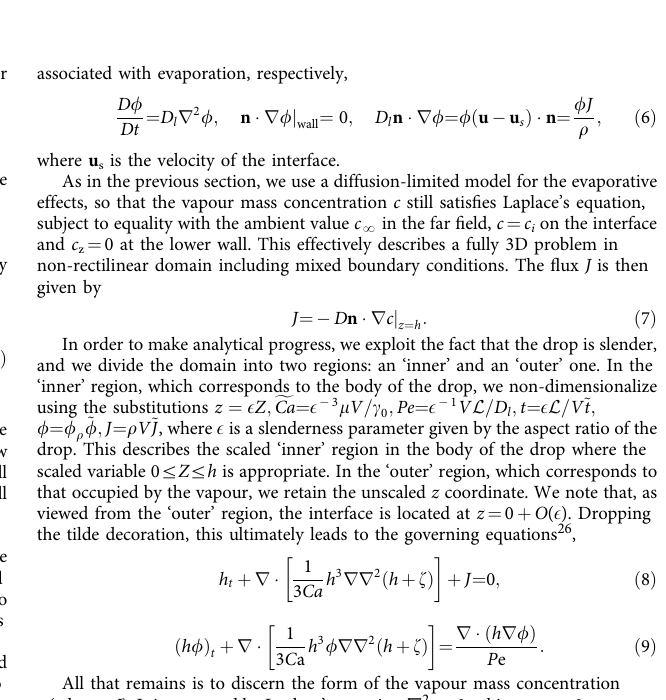
Figure 9 | Local evaporation flux. Parameter values are as in Fig. 8. ( a ) Two-dimensional plot of the flux, J ; ( b ) overlaid height (solid line) and flux (dashed) line corresponding to dashed white line in a , demonstrating the enhanced flux nearer the apices. The parameter values are the same as those used to generate Fig.